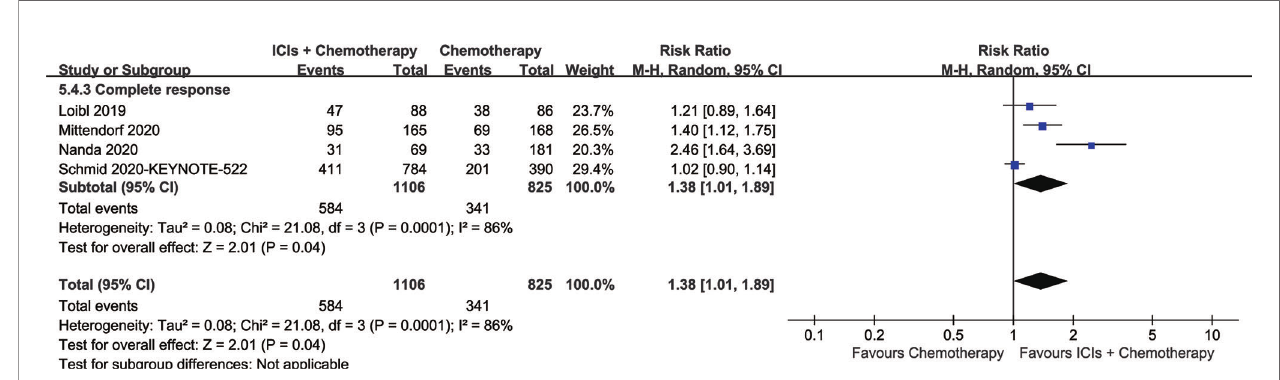
FIGURE 4 | Forest plots of CR associated with ICIs+Chemotherapy versus Chemotherapy.